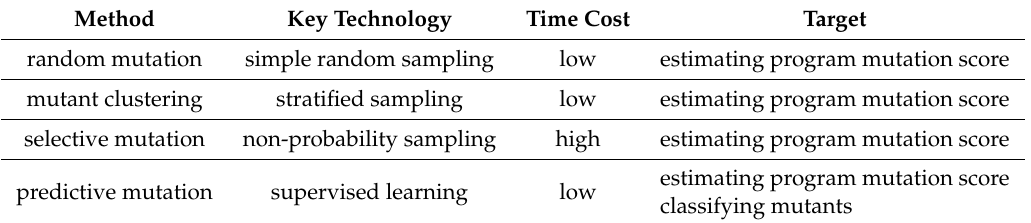
Table 1. Main differences among mutation reduction